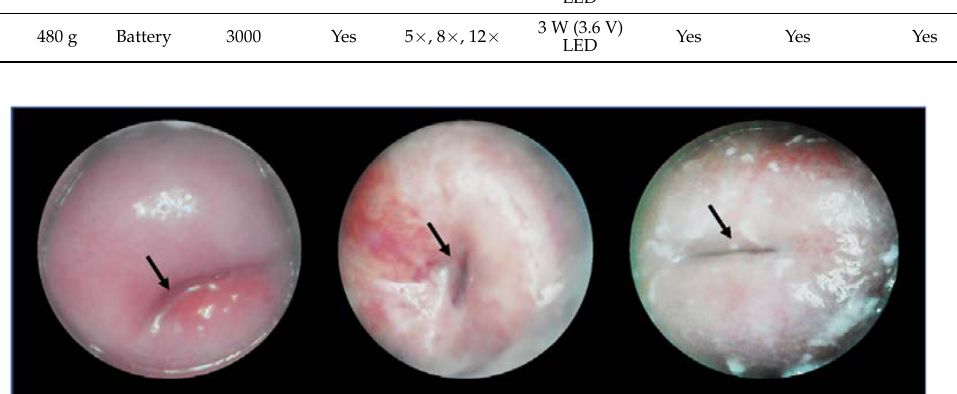
Figure 7. Sample images taken with the Callascope while self-imaging. The arrow points to the cervical external os (Reprinted from Ref. [40]).